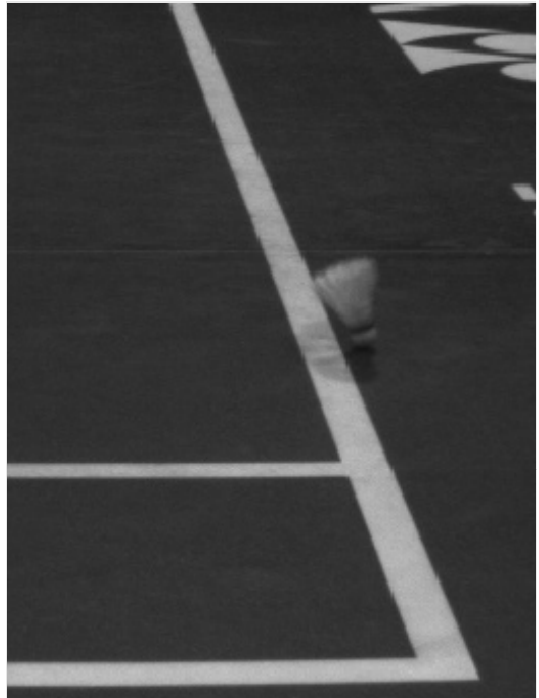
Figure 14. Ground Figure 14. Ground hit. Figure 14. Ground hit.